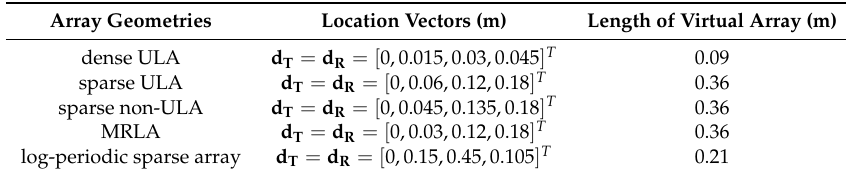
Table 4. Array geometries for MIMO GMTI radar.